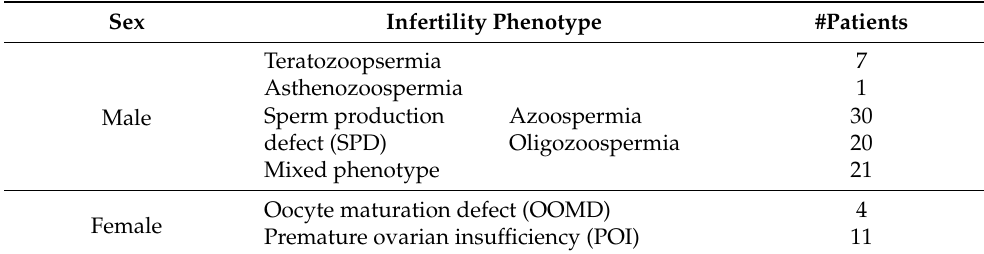
Table 1. Infertility phenotype and sex of the recruited patients. The number of patients in each group is